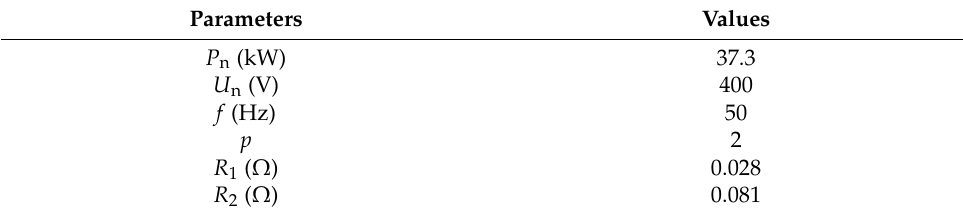
Table A1. Parameters of the considered induction